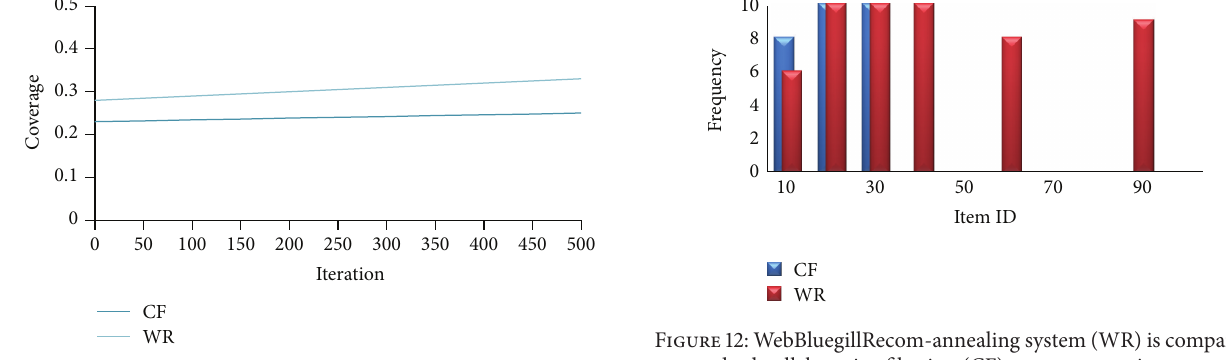
Figure 10: WebBluegillRecom-annealing system (WR) is compared to standard collaborative filtering (CF) system on coverage, 𝐼 = 5 , 248 users.